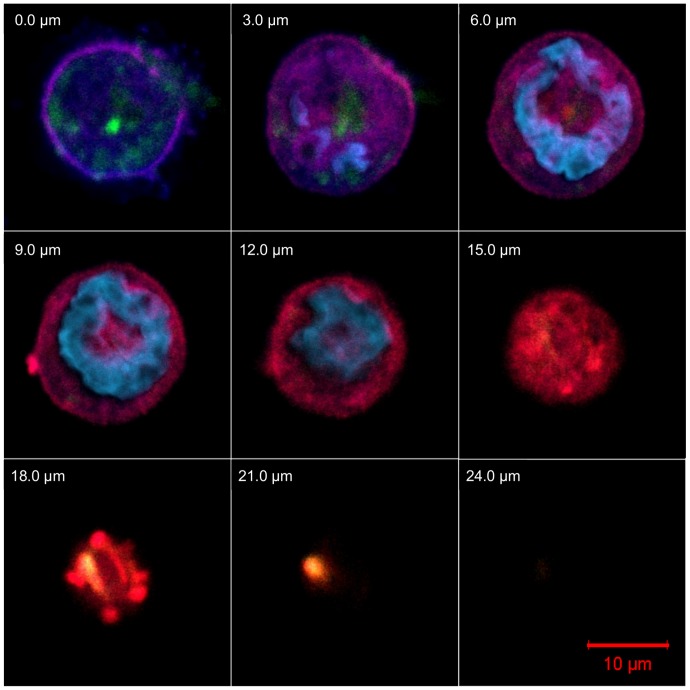
FITC-RAMEB colocalized with Rab5 proteins.RFP-Rab5a transfected Caco-2 cells were treated with 0.05 mM FITC-RAMEB (green) for 30 minutes. Colocalization is indicated by yellow pixels in the confocal microscopic images on the sections marked by the 18-micrometer and 21-micrometer label. Figure shows nine subsequent, three-micrometer thick confocal sections giving altogether a twenty-four-micrometer cross layer of a Caco-2 cell. CellMask (dark blue) was used for labeling membrane at the cell surface and nucleus was stained by DAPI (light blue). Rab5 proteins (red) are visualized by transient transfection of a plasmid coding Red Fluorescent Protein (RFP) tagged Rab5.